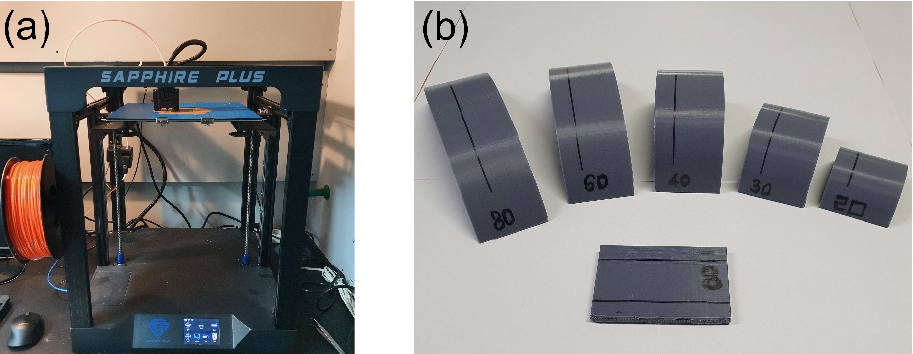
bending curvature, the change in resistance and the initial resistance, respectively.